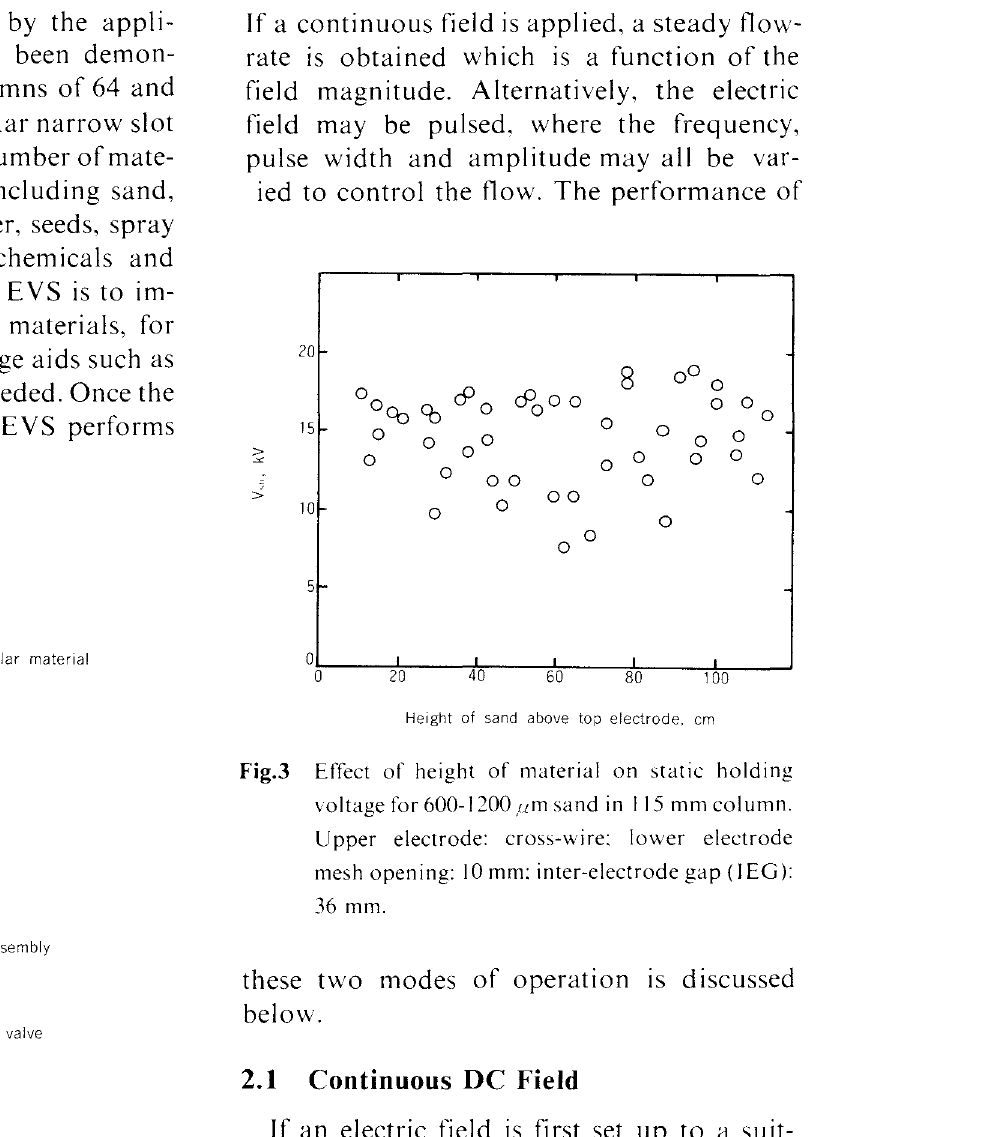
Schematic diagram of test rig for measuring flmHate through EVS.